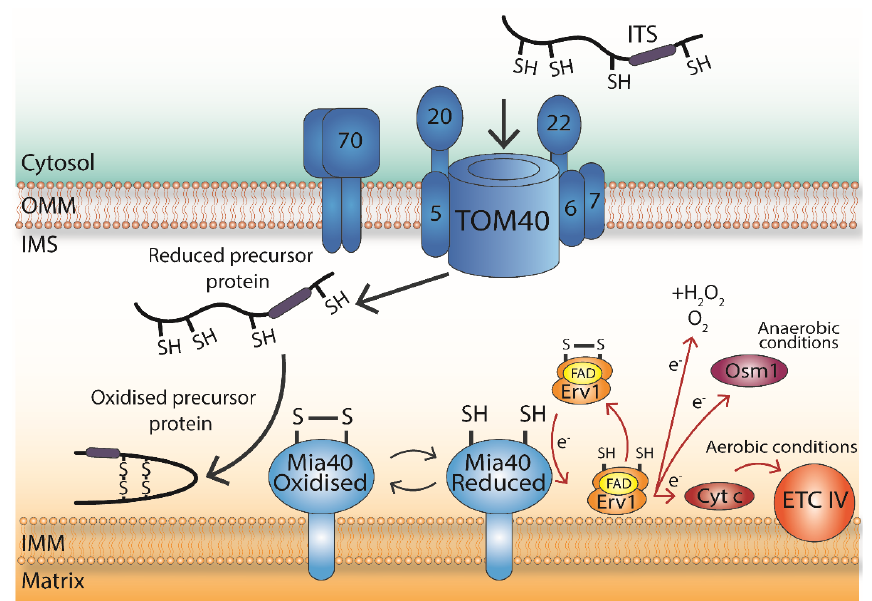
Figure 1. Mechanism and basic players of the MIA pathway. Incoming nuclear-encoded and cysteine-bearing proteins destined for the intermembrane space (IMS)-localised MIA pathway are firstly translocated through the Tranlocase of the Outer Membrane TOM complex. The ITS (IMS-Targeting Signal, shown in purple) interacts with Mia40 through the “sliding–docking” model. Following interaction with Mia40, the substrate is released in an oxidised and stably folded conformation. The Cysteine-Proline-Cysteine CPC motif of Mia40 is left in a reduced state and requires re-oxidation to continue participating in import reactions. The re-oxidation of Mia40 is facilitated by Erv1, and then, the electrons are passed directly to molecular oxygen (resulting in the production of hydrogen peroxide), or to cytochrome c and respiratory chain complex IV in aerobic conditions, or to Osm1 in anaerobic conditions. Overall, the MIA pathway inserts disulphide bonds into proteins, trapping them in the IMS of mitochondria.